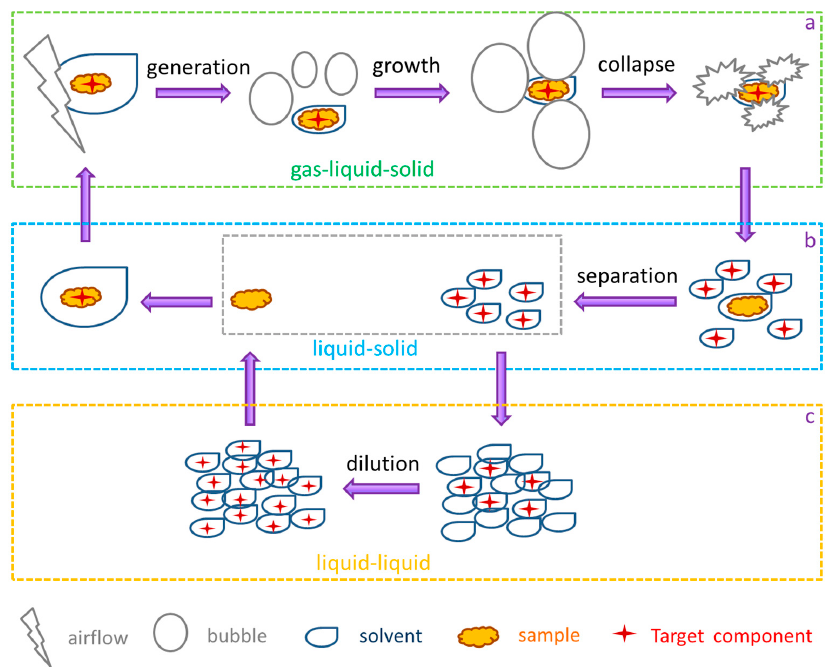
Figure 4. Schematic diagram of the gas–liquid–solid conversion ( a ); the liquid-solid conversion ( b ); and the liquid-liquid conversion ( c ) in the vacuum-powered bubble extraction process Under negative driving pressure, the air bubbles rose and grew and the larger the negative driving pressure, the faster the bubbles expanded [28]. After expanding, the bubbles collapsed on the surface of the solvent along with the outside lower pressure. As shown in Figure 4a, the bubbles’ collapse the solvent diffused into the inside of the solid particles enhancing the intra-particle diffusion. The